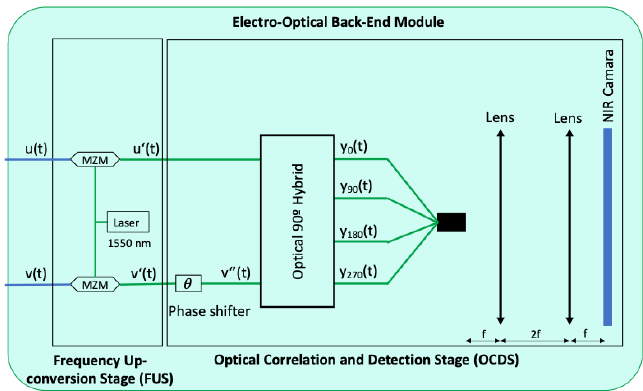
Figure 3. Block diagram of the electro-optical back-end module built on the